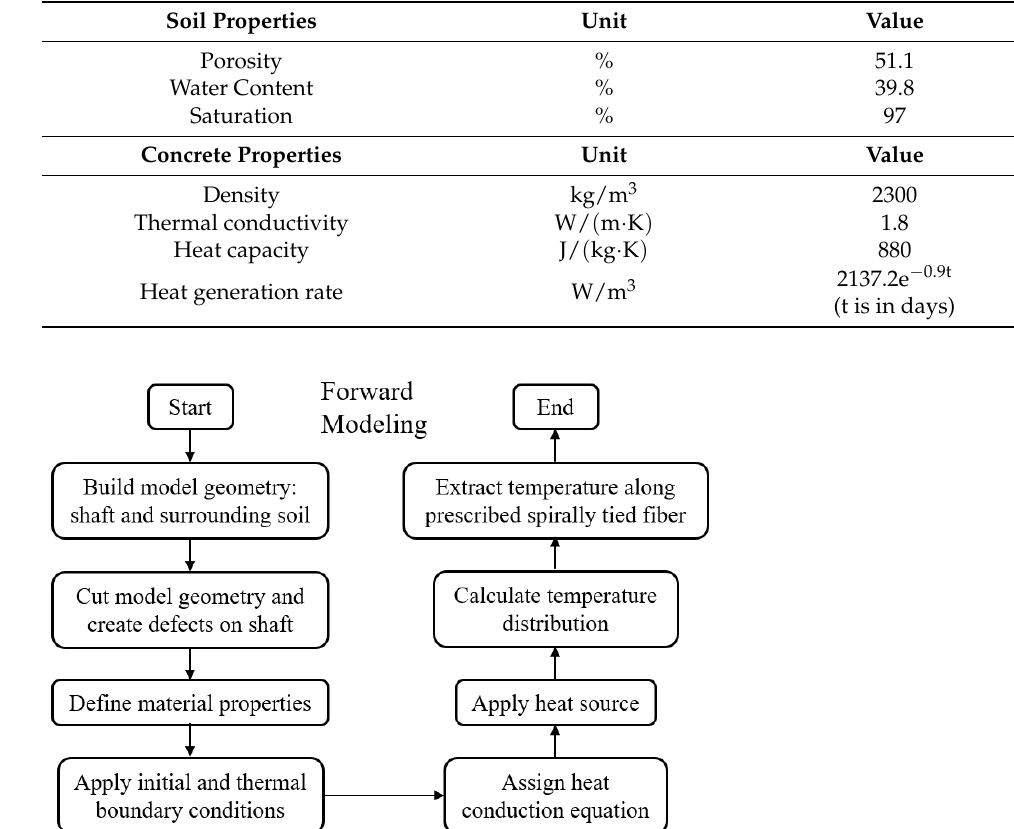
Figure 2. Simulation flowchart of the forward modeling for fiber optic-based TIP with spiral deployment.